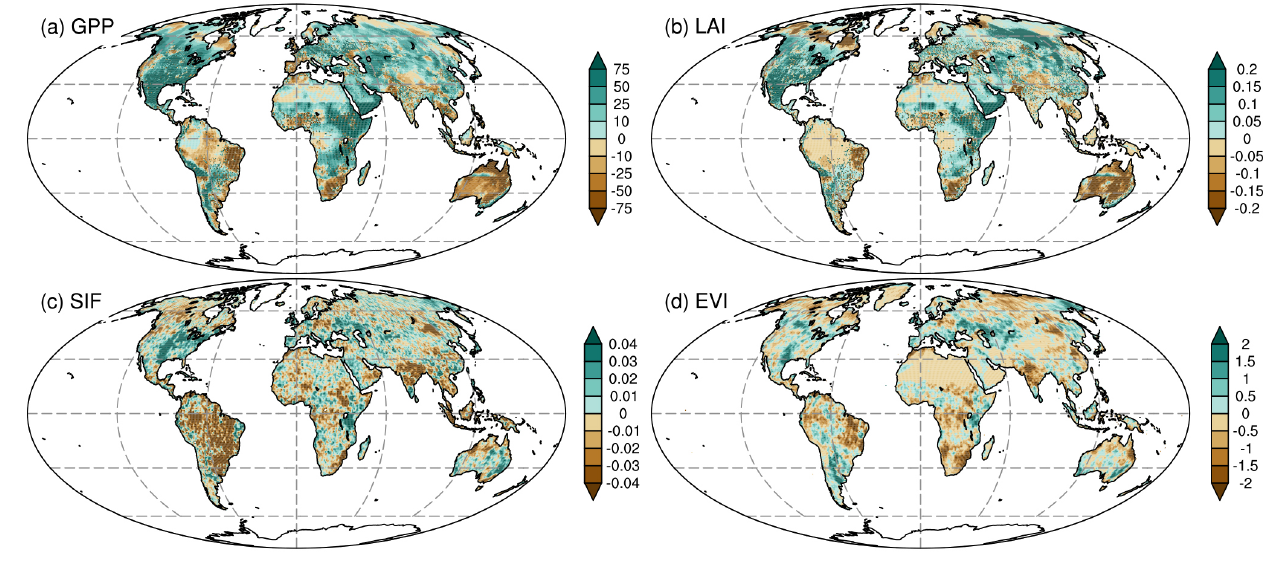
Figure 7. Spatial anomalies in (a) the simulated GPP by VEGAS (units: gCm − 2 yr − 1 ), (b) the simulated leaf area index (LAI; units: m 2 m − 2 ), (c) solar-induced chlorophyll fluorescence (SIF; units: mWm − 2 nm − 1 sr − 1 ), and (d) MODIS enhanced vegetation index (EVI, × 10 − 2 ) from July 2015 to October